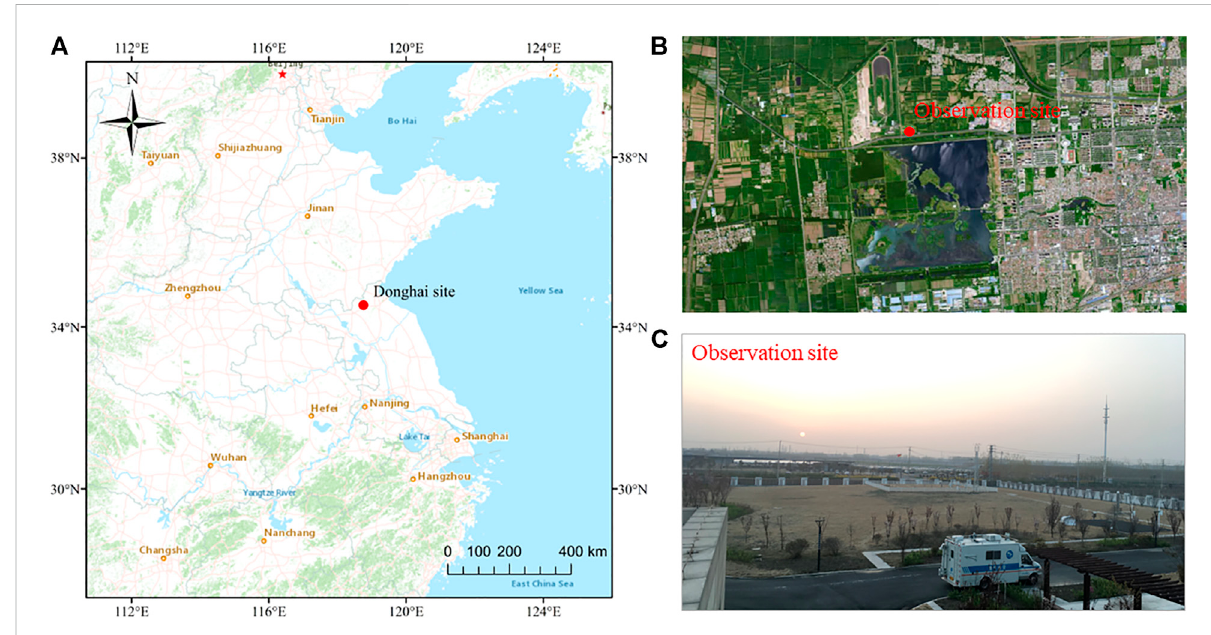
FIGURE 1 (A) Geographical location of the Donghai site in Jiangsu Province, China, (B) surrounding of the observation site, and (C) photo of the observation